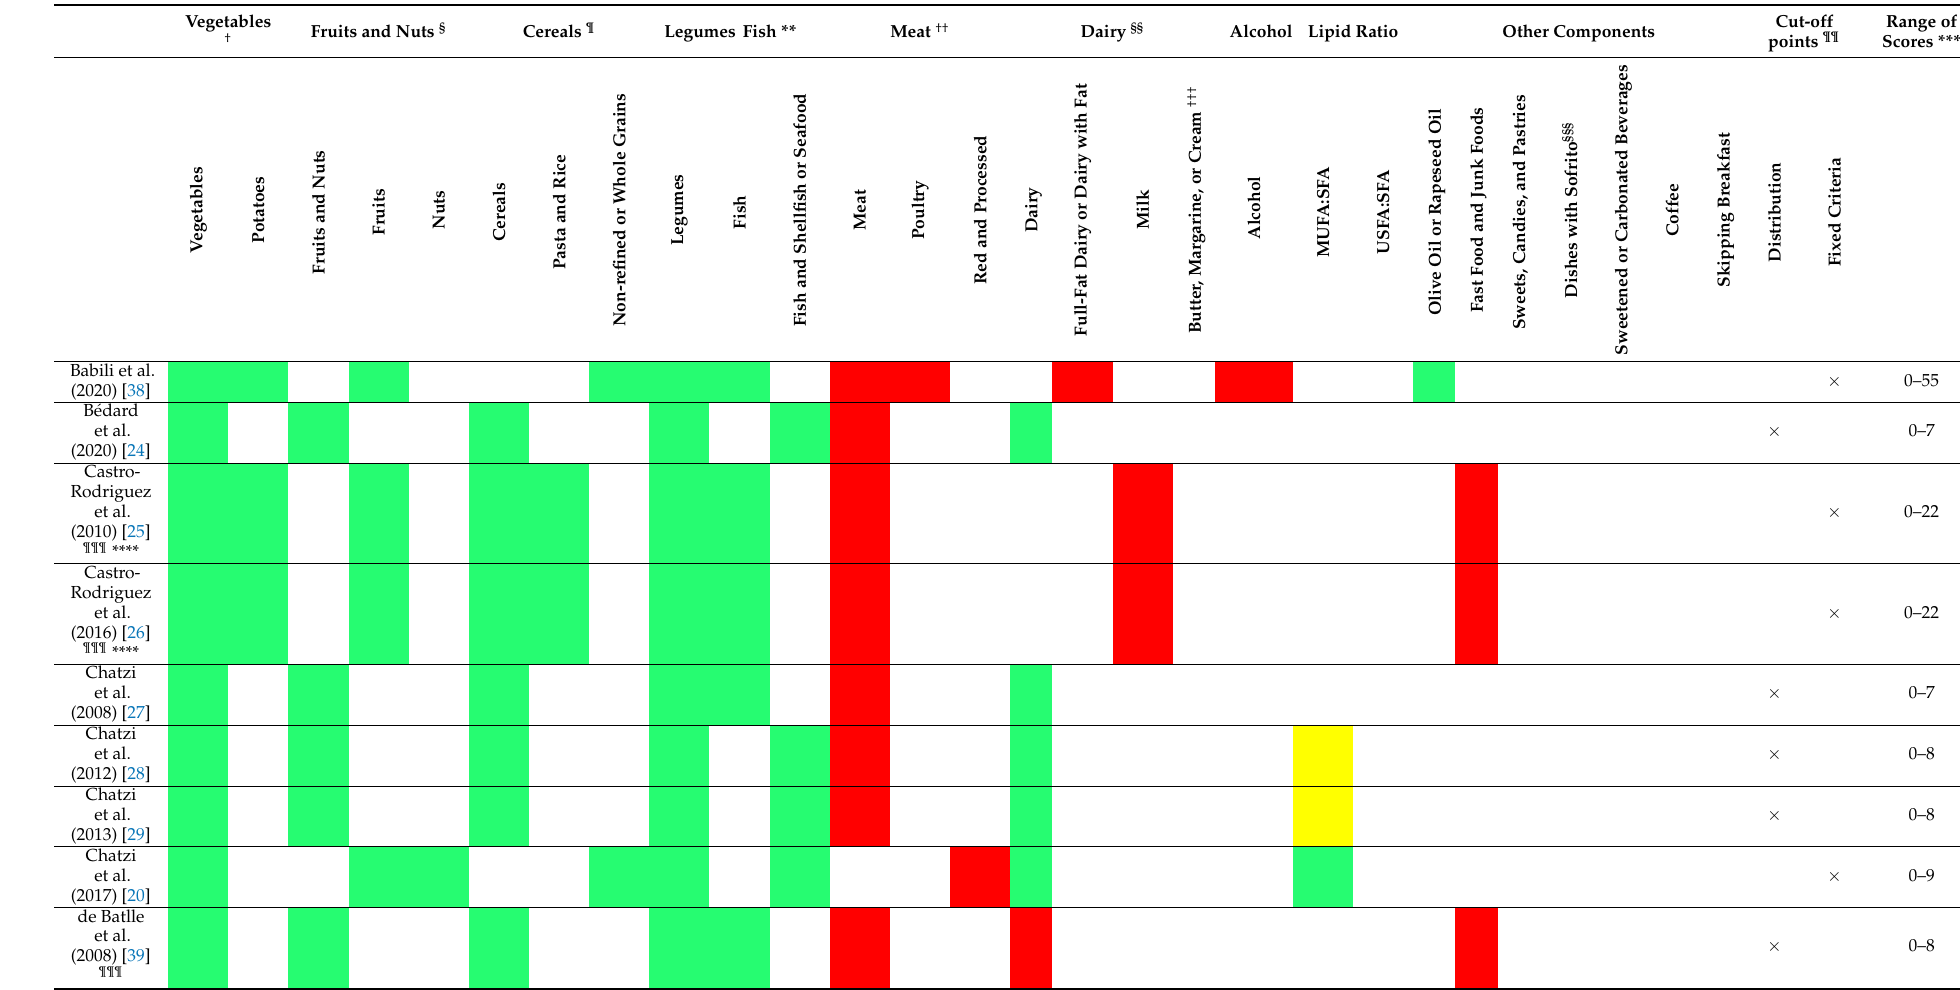
Table 3. Compa ison of food and nutrient components *, cut-off points, and range of scores in a priori indexes assessing maternal adherence to the MD during pregnancy. Vegetables